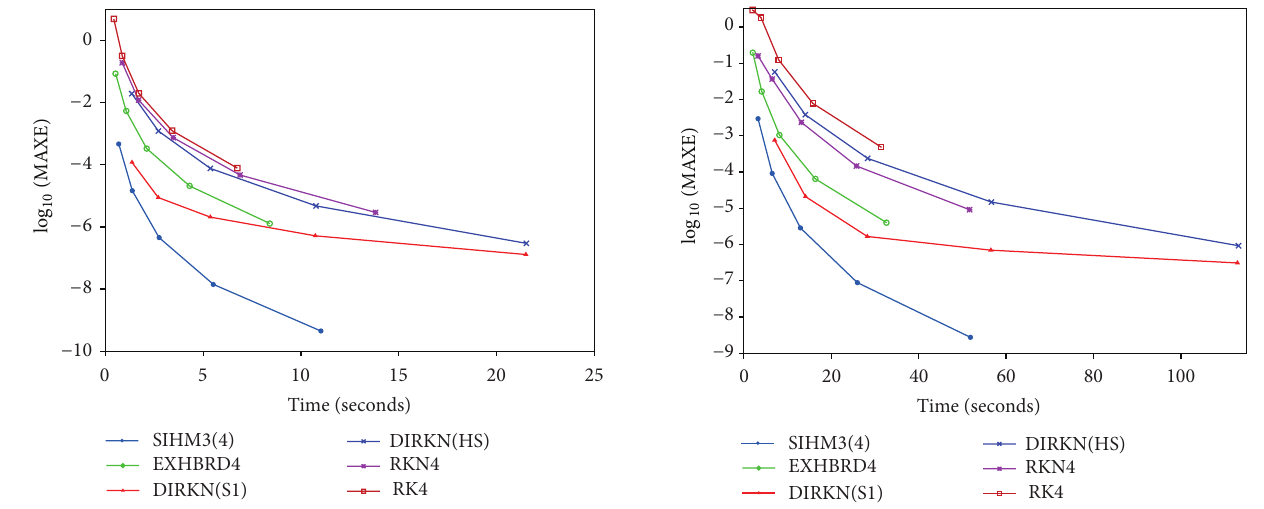
Figure 1: The efficiency curves for SIHM3 (4) method for Chawla and Rao problem with ℎ = 0.125/2 𝑖 , 𝑖 = 3,...,7 .